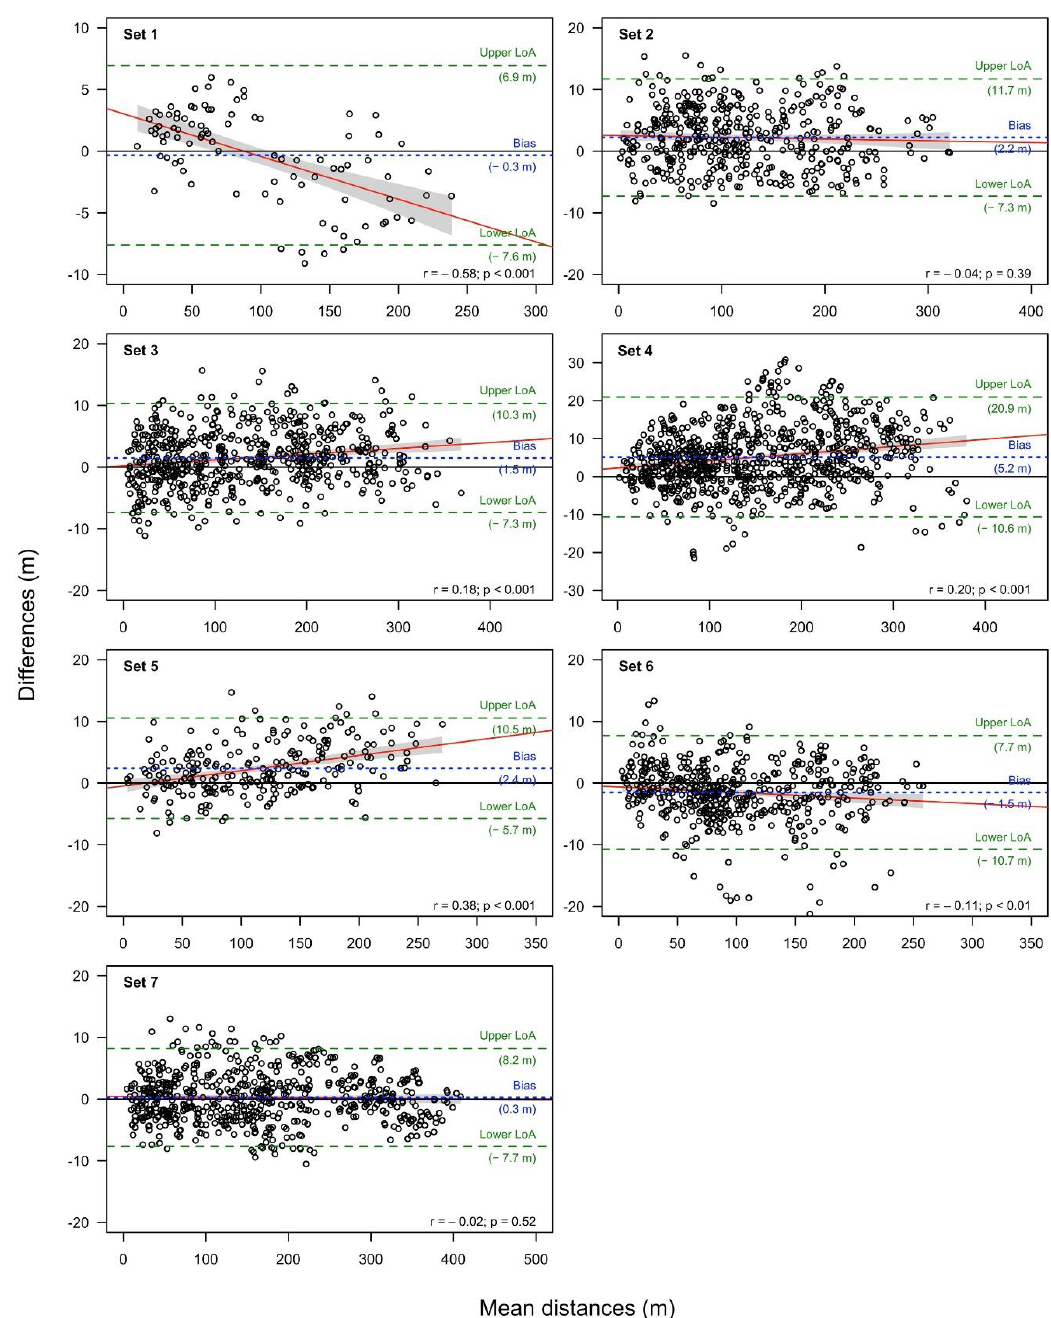
Figure 4. Results of the Bland–Altman analysis and linear regression for the datasets, including all distances between points (nests). Note: the red line shows the regression between bias and mean